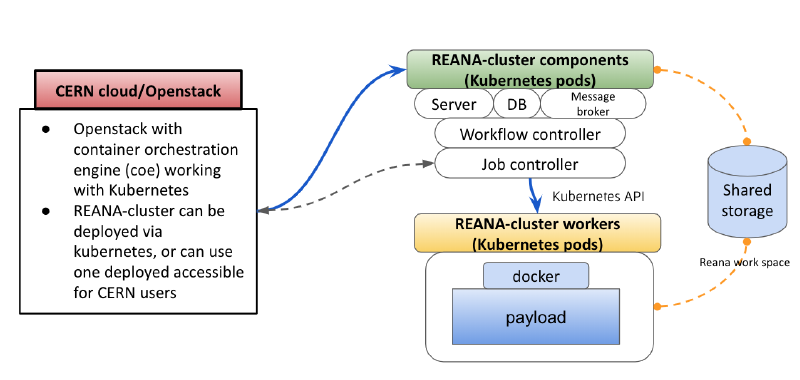
Figure 1. REANA cluster deployment via